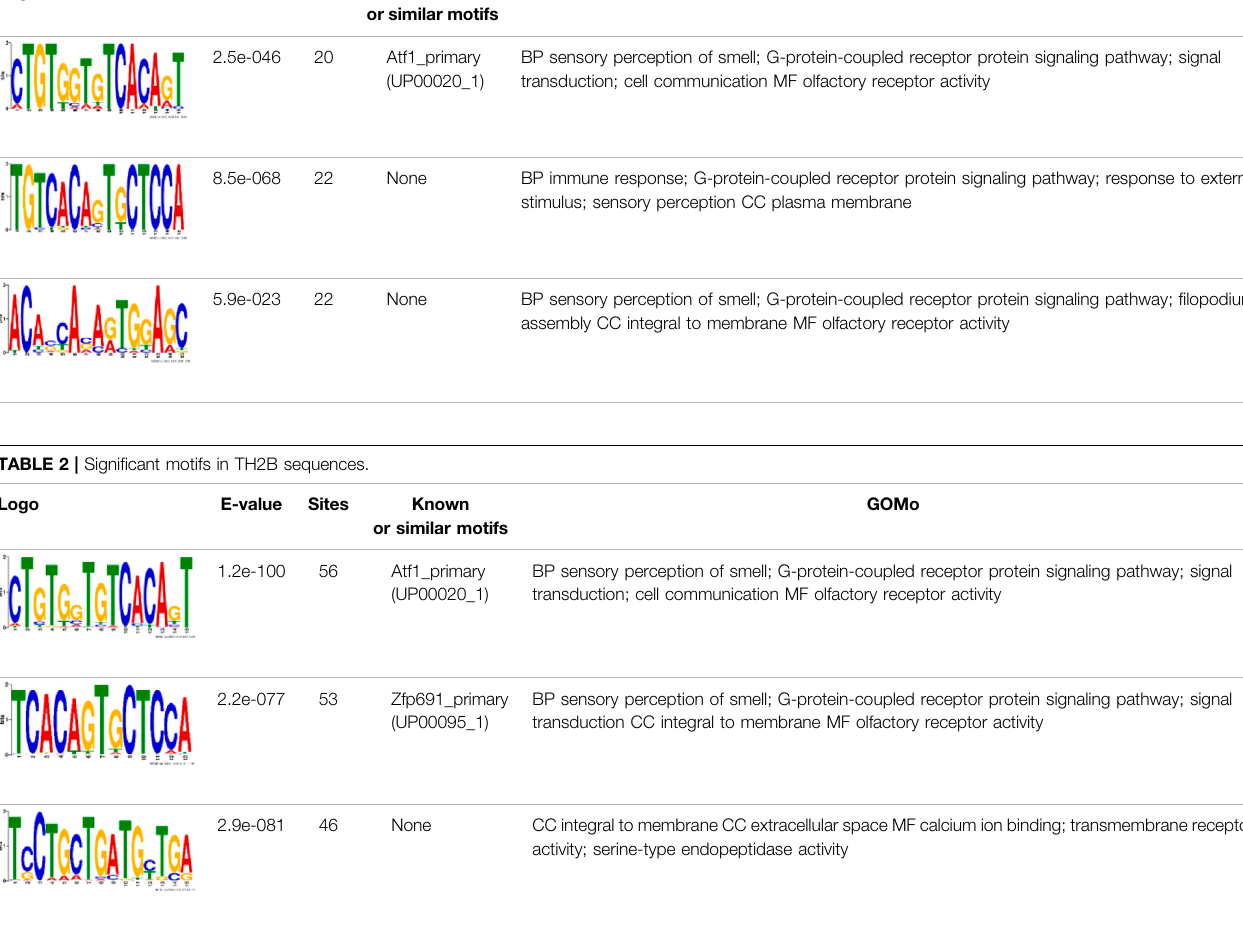
or similar motifs